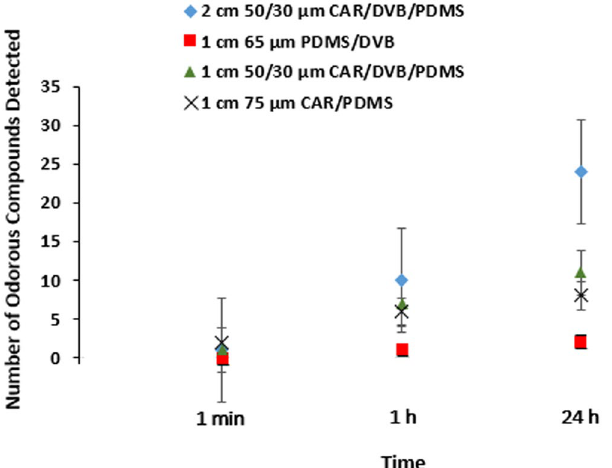
Figure 1. Effects of extraction sampling time (1 min, 1 h, 24 h) and SPME fiber type on the number of odorous compounds detected through sensory analysis (n = 3 replicates) with standard error